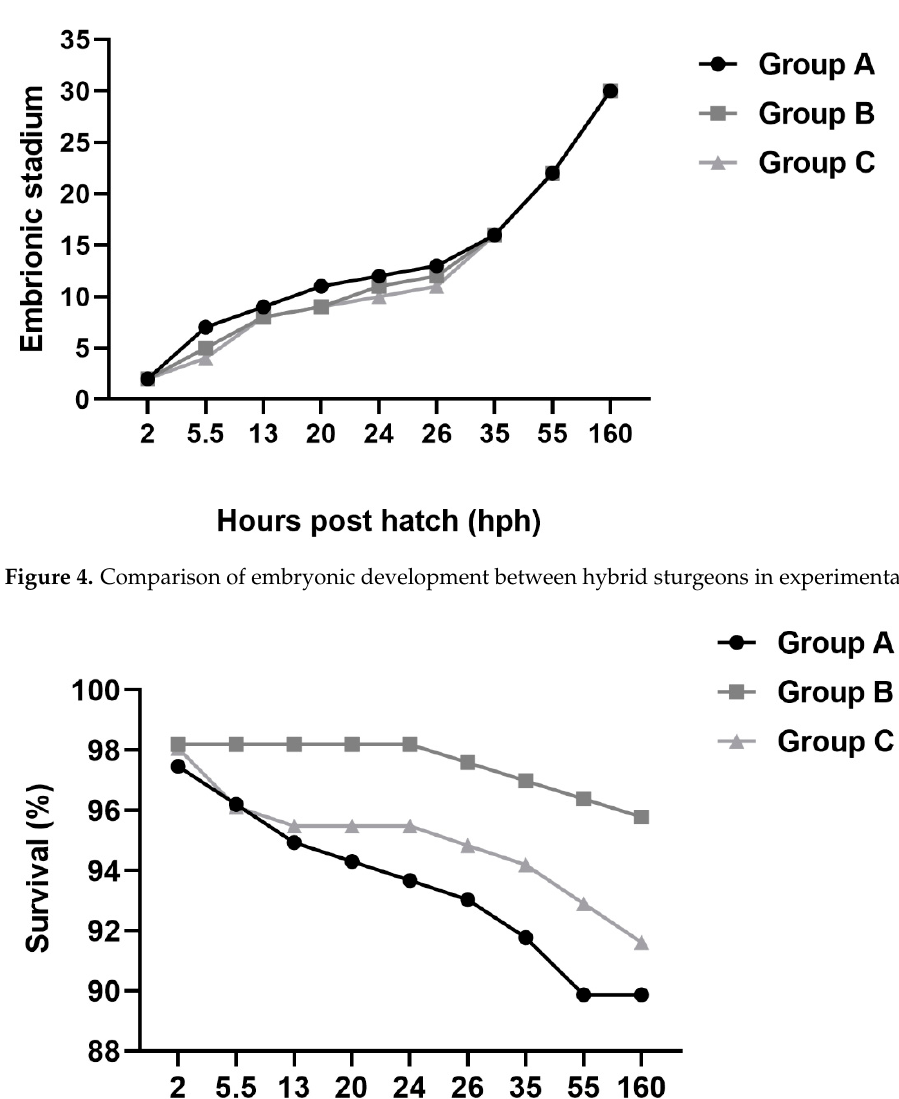
Figure 3. Embryonic development of Siberian sturgeon ( ♀ Siberian sturgeon × ♂ Siberian) offspring (group C—control) according to Park et al. [10].